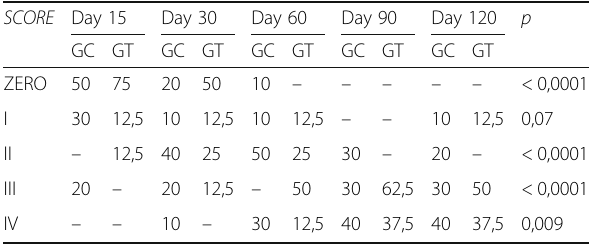
Table 1 Classification of ossification (%), according to Hoffman et al. 2006, of the animals from the control group (GC) and those treated with mesenchymal stem cells group (GT) throughout the evaluation period